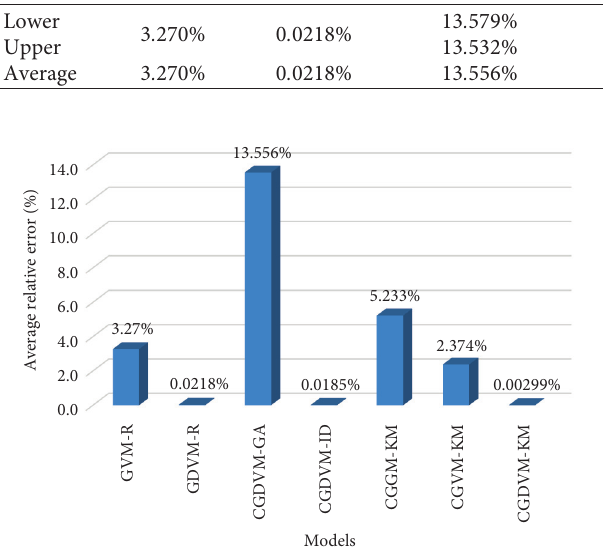
Figure 3: Prediction error of different